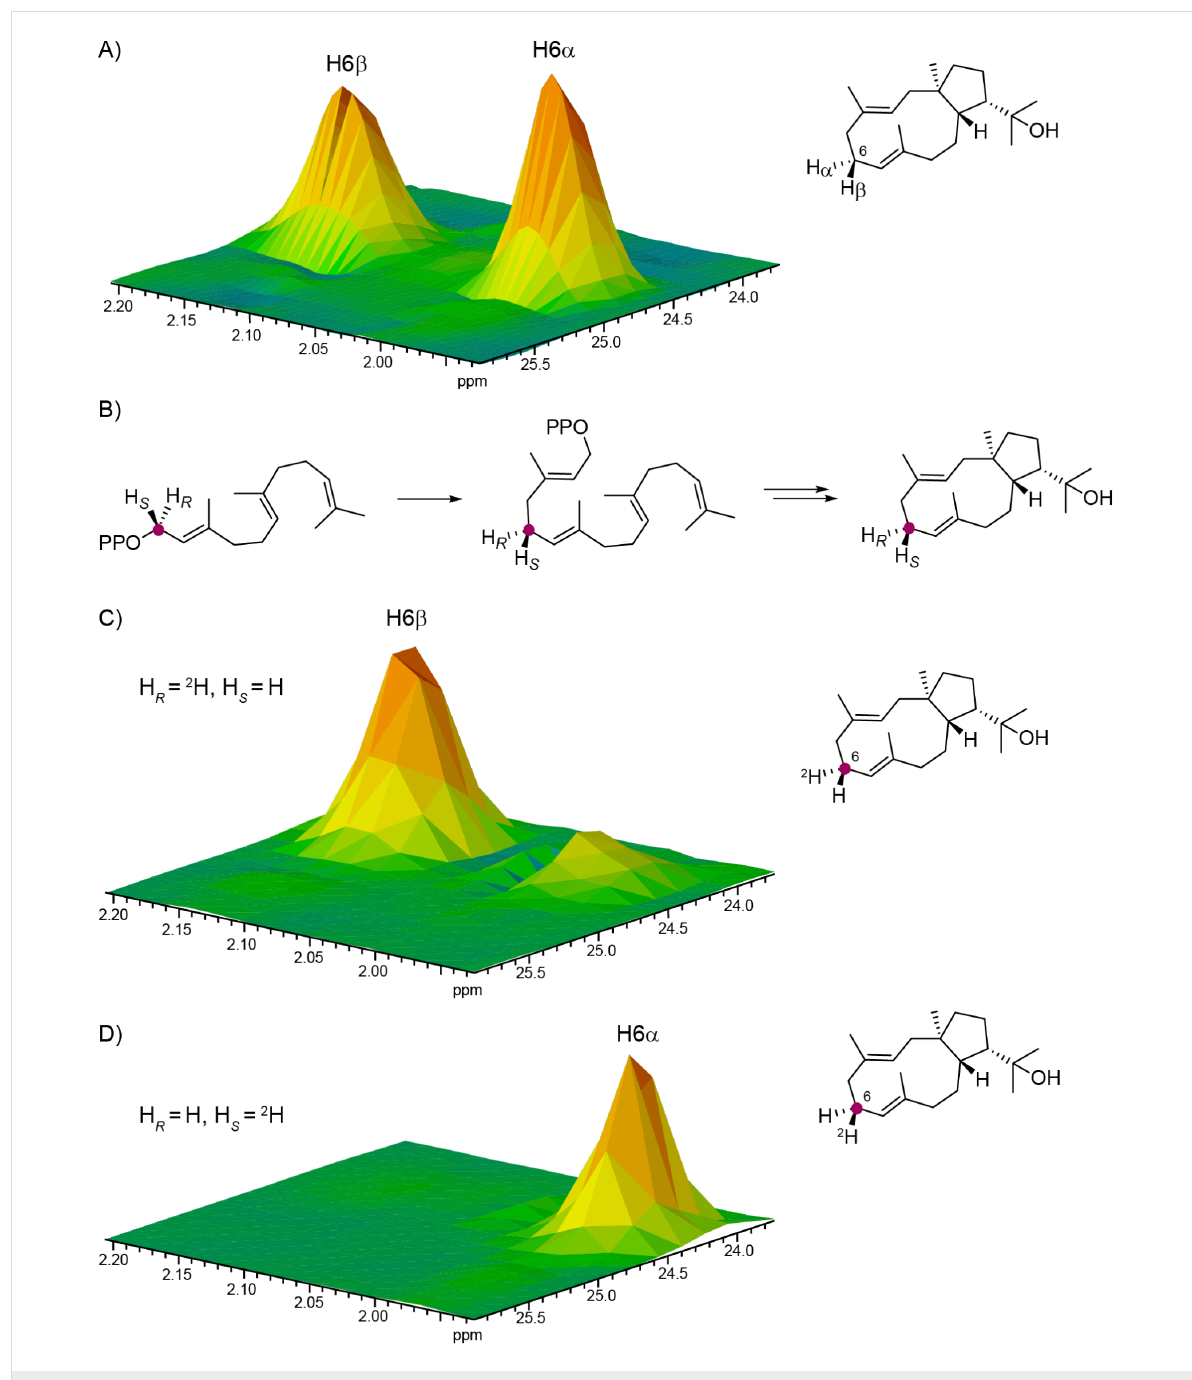
Figure 4: Assignment of H6 α and H6 β of 3 . (A) Partial HSQC spectrum of unlabelled 3 showing the region for C6, (B) elongation of FPP with IPP to GGPP and cyclisation to 3 , (C) partial HSQC spectrum of the product obtained from ( R )-(1- 13 C,1- 2 H)FPP, and (D) partial HSQC spectrum of the prod- uct obtained from ( S )-(1- 13 C,1- 2 H)FPP. Purple dots indicate 13 C-labelled